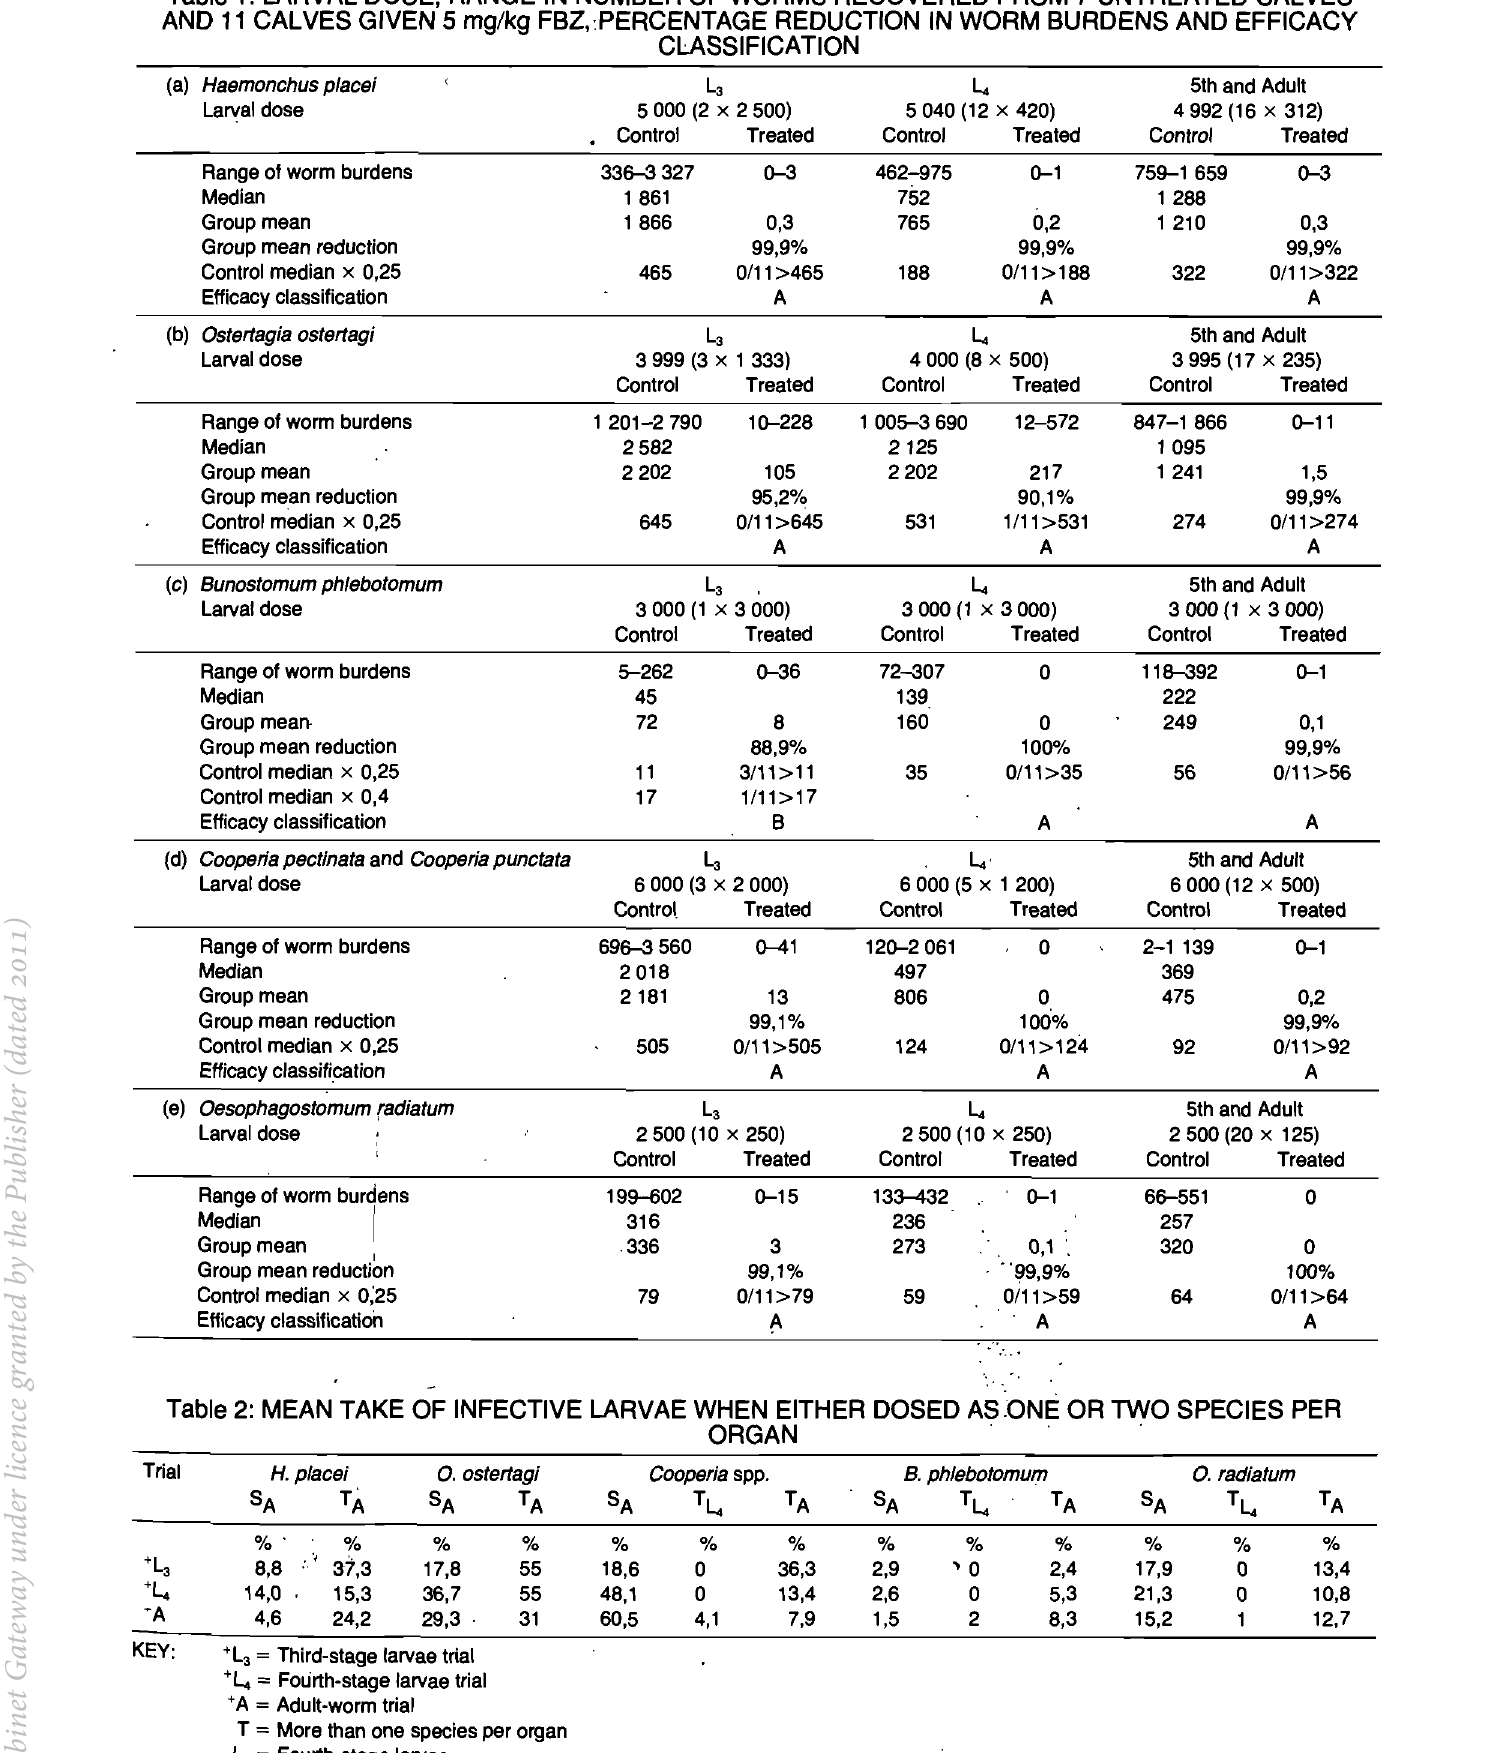
Table 1: LARVAL DOSE, RANGE IN NUMBER OF WORMS RECOVERED FROM 7 UNTREATED CALVES AND 11 CALVES GIVEN 5 mg/kg FBZ.:PERCENTAGE REDUCTION IN WORM BURDENS AND EFFICACY